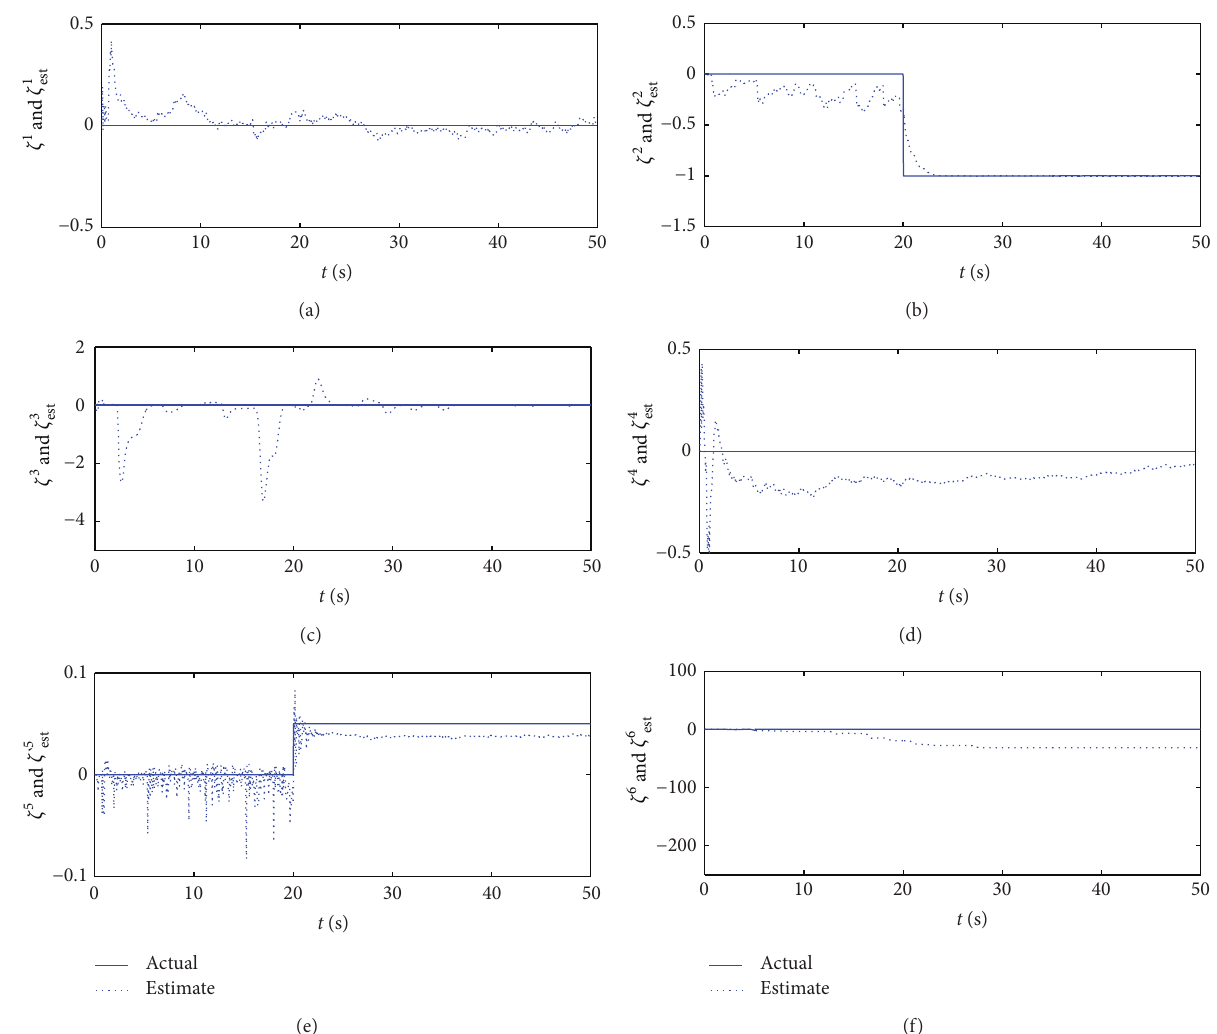
Figure 4: Actual inputs and estimations when a stuck actuator fault in stabilizer occurred at 20 seconds.